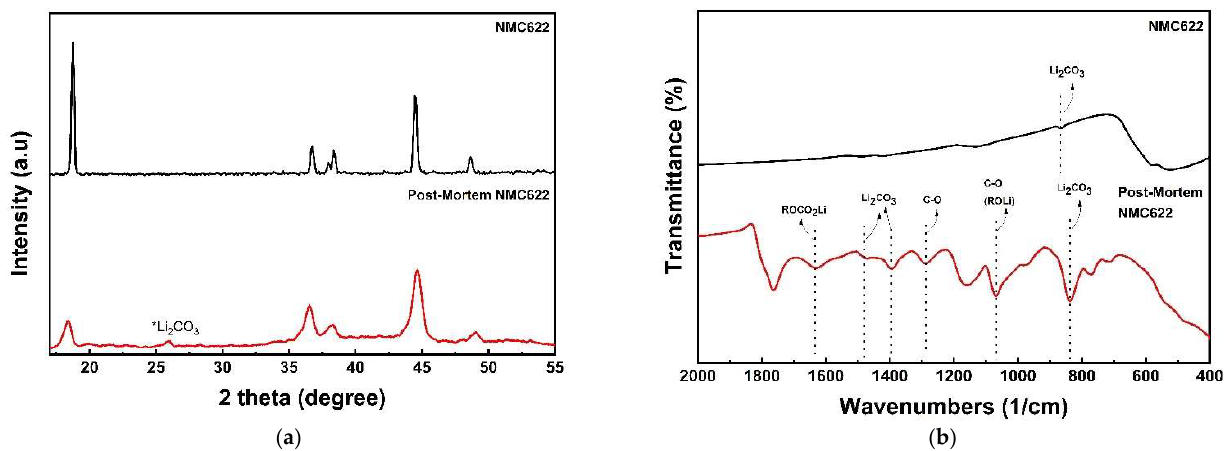
Figure 11. Postmortem analysis of NMC622; ( a ) X-ray Diffractometer pattern and ( b ) FTIR spectra.